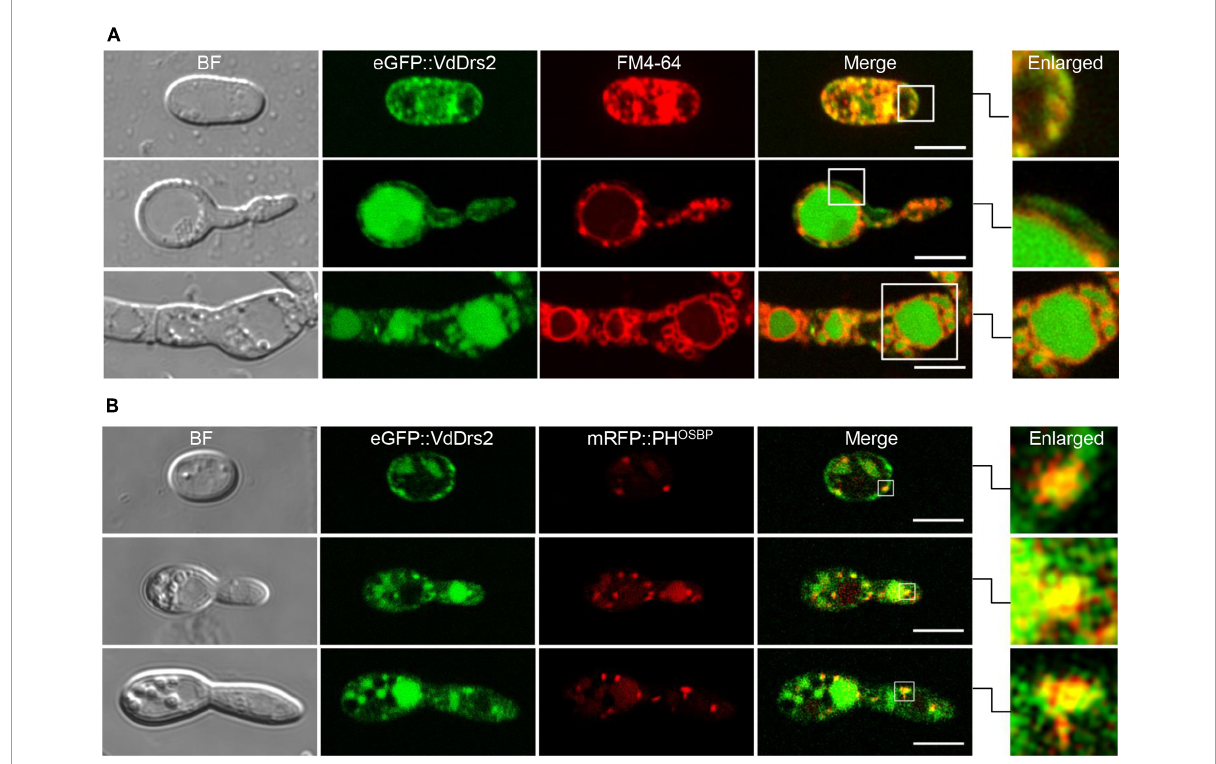
FIGURE4 VdDrs2 is localized to plasma membrane, vacuoles and trans -Golgi network (TGN). (A) Confocal imaging of eGFP::VdDrs2 (green, Ex = 488 nm, Em = 500–530 nm) in different growth stages of V. dahliae . The plasma membrane and vacuoles were stained by FM4-64. BF, bright field; Merge, the green fluorescence image is merged with red fluorescence image; Enlarged, each boxed area on the right is enlarged from the white box in merge. Scale bars represent 5 µ m. The images were captured with confocal microscope (Leica SP8, Wetzlar, Germany). (B) VdDrs2 and PH OSBP were colocalized in cells at different growth stages of V. dahliae . PH OSBP , the pleckstrin homology domain of the human oxysterol binding protein, was used to indicate the location of TGN. BF, bright field; Merge, the green fluorescence image is merged with red fluorescence image; Enlarged, each boxed area on the right is enlarged from the white box in merge. Scale bars represent 5 µ